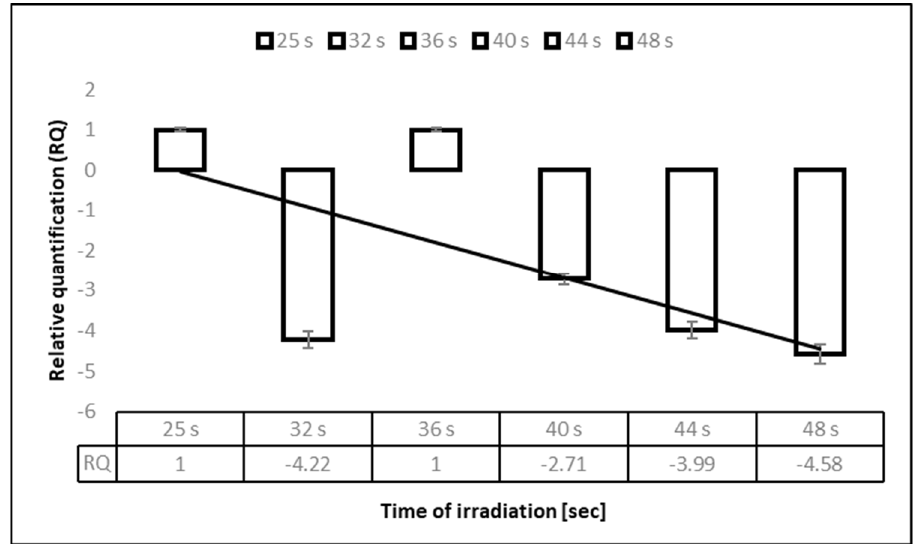
Figure 3. Relative quantification of viral RNA after exposure to 275 nm UV-C. Legend: RNA quality was determined by ratio of A260/ 280 = 2.0 in water free of nucleases. Quantification was performed in duplicate with the total RNA concentration being the same in every sample. Relative quantification was calculated using the formula RQ = Cq control − Cq sample, where the control was nonirradiated HCoV-OC43 harvested in a medium for seven days.